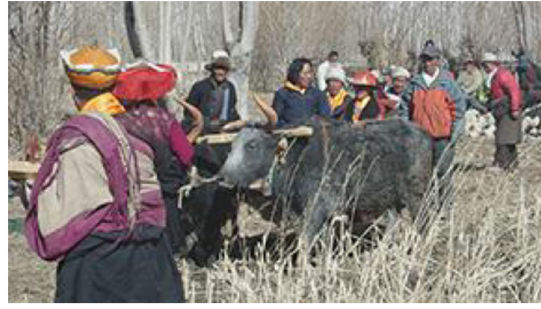
Fig. 15 Thrashing machine: A beginning of technological